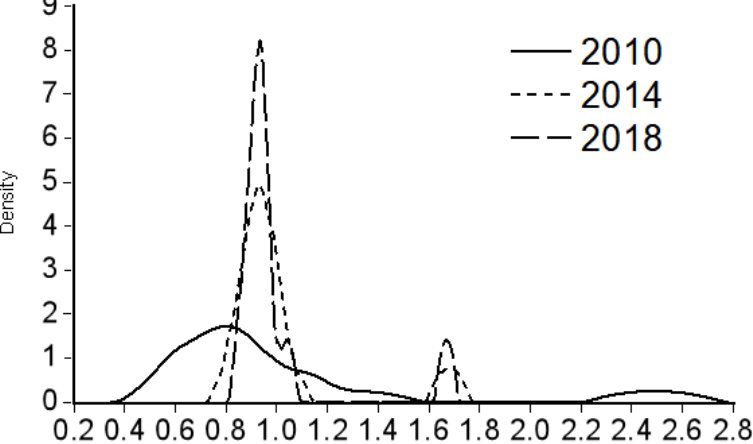
Figure 2. Kernel density estimation of the number of health personnel per 10,000 people in the central economic belt provinces. economic belt provinces.